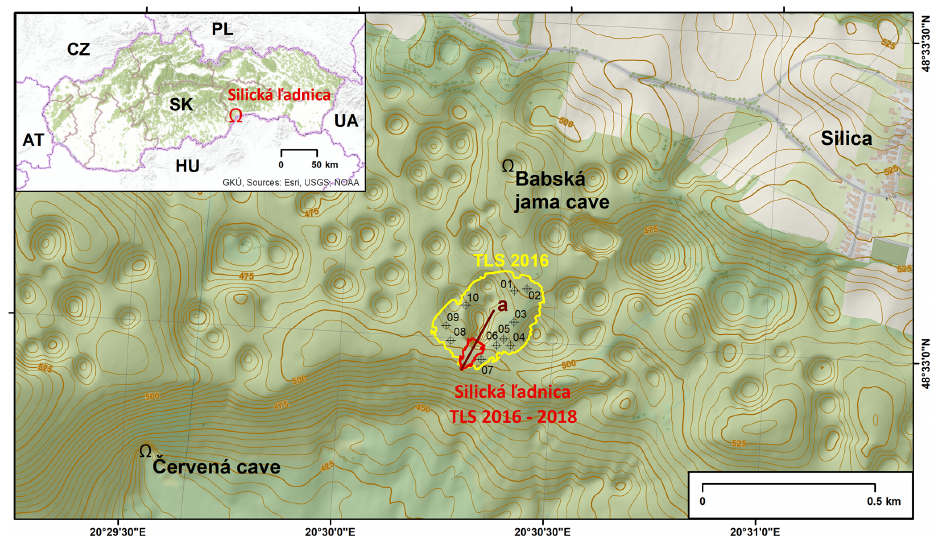
Figure 1. Location of the Silická l’adnica cave. The polygons represent the territory mapped by the TLS method – yellow outline delineates the area of scan mission 1 in 2016, and the red outline represents the area of other scan missions used to build a time series of TLS data. Contours and shaded relief improve the perception of numerous sinkholes on the plateau of Silická planina, which tend to have a regular funnel shape. The dark brown line denoted with “a” marks the vertical profile shown in Fig. 7. Numbered black crosshairs in a circle locate the ground control points used for registration into the common global coordinate system. Base maps: ©2019 GKÚ and ©2019 Esri.